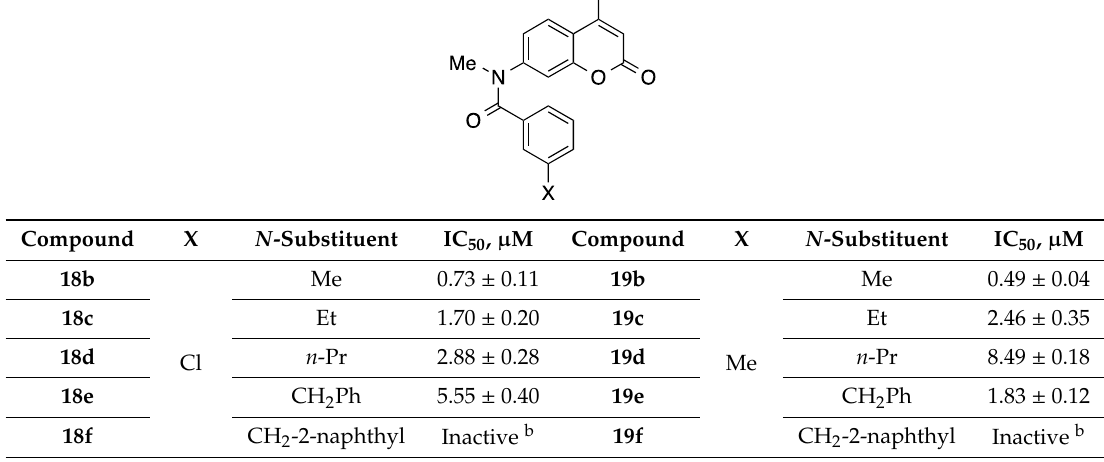
Table 3. AR-antagonistic activity of coumarinamide derivatives in SC-3 cell assay a .